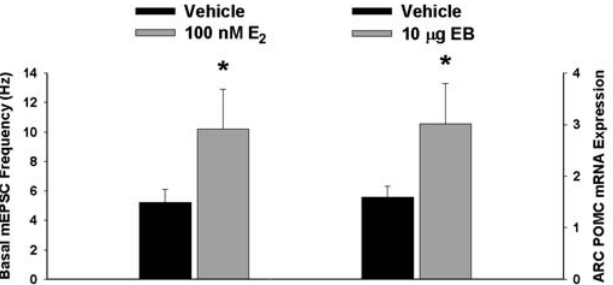
Figure 5. Estrogens increase basal mEPSC frequency and POMC expression. Bars represent means and vertical lines 1 SEM of the basal mEPSC frequency and POMC mRNA expression in the ARC. *, Values measured in E -treated slices or EB-treated animals that 2 are significantly different (Student’s t-test; p < 0.05; n = 5 − 8) than those measured in vehicle-treated controls.